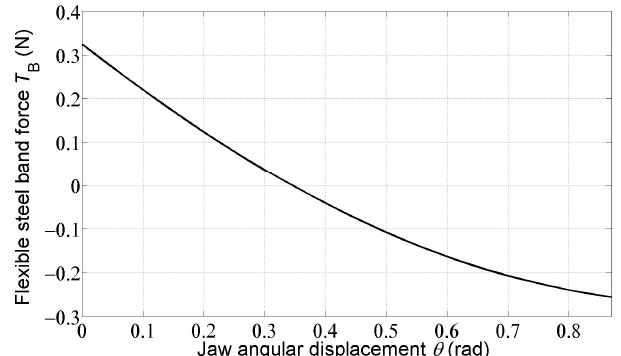
T on the jaw angular displacement θ B